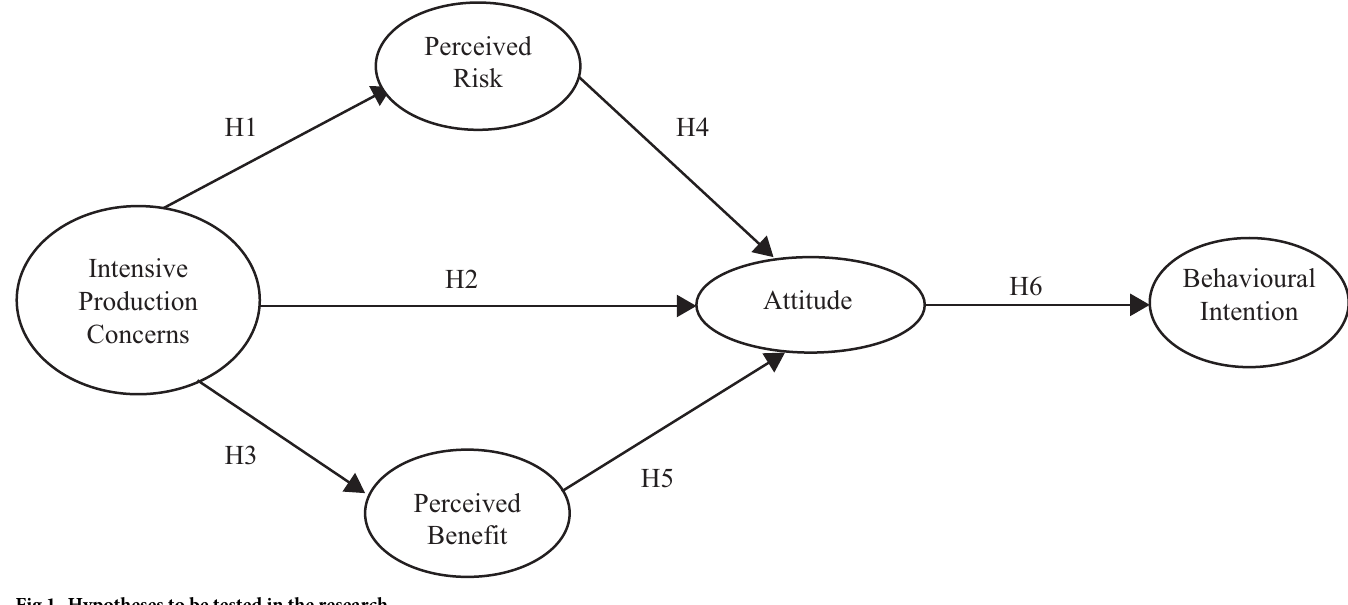
Fig 1. Hypotheses to be tested in the